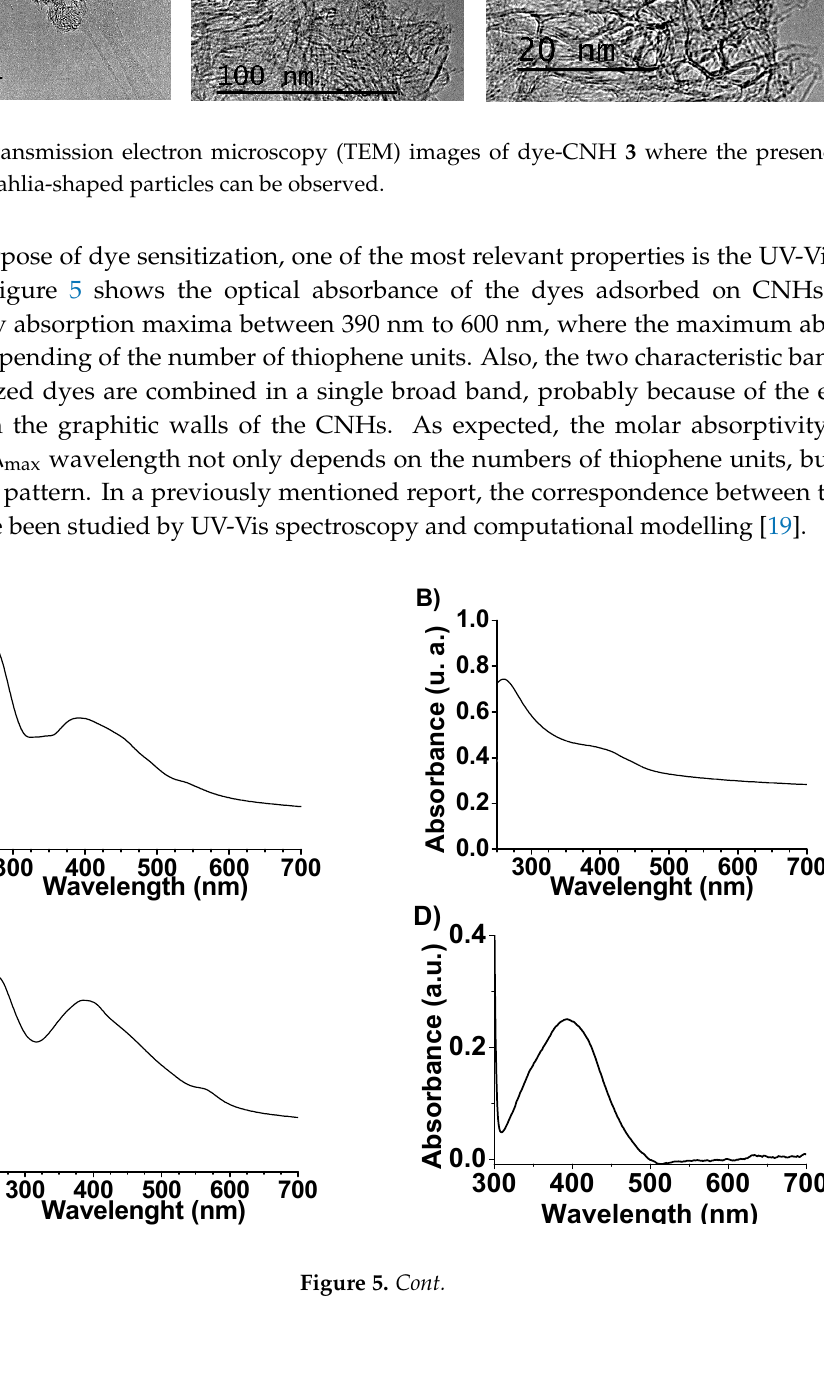
Figure 4. Transmission electron microscopy (TEM) images of dye-CNH 3 where the presence of individual dahlia-shaped particles can be observed.